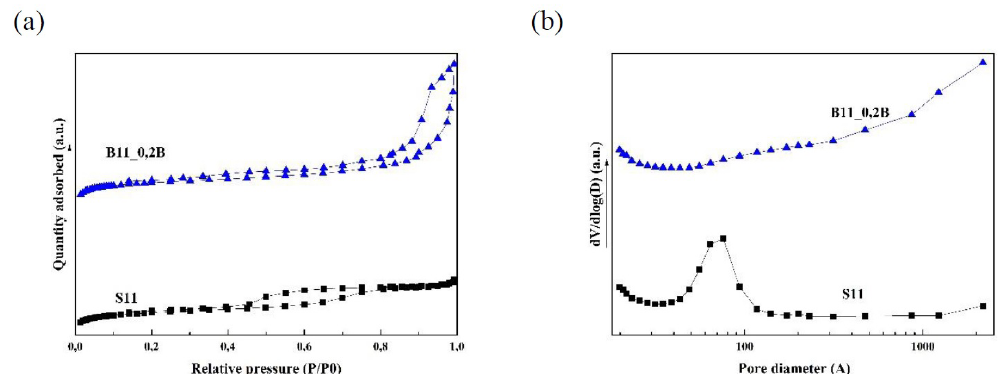
adsorption/desorption and (b) pore distribution of AEL structure Figure 12. (a) Isotherms of N 2